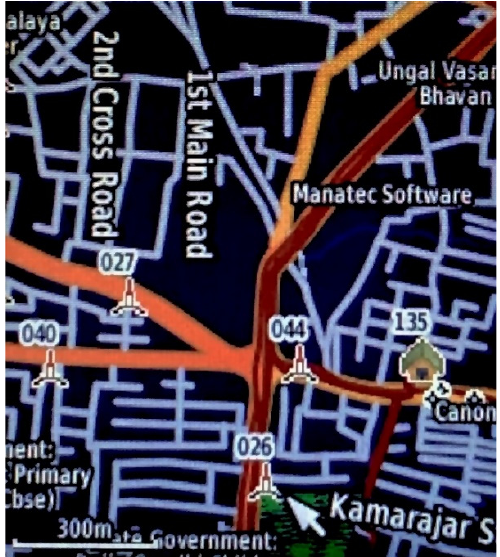
Figure 1 . Geographical mapping of cell phone towers using Garmin etrex 20× device . The short Figure 1. Geographical mapping of cell phone towers using Garmin etrex 20 × device. The short white arrow indicates the cell phone tower. white arrow indicates the cell phone tower.